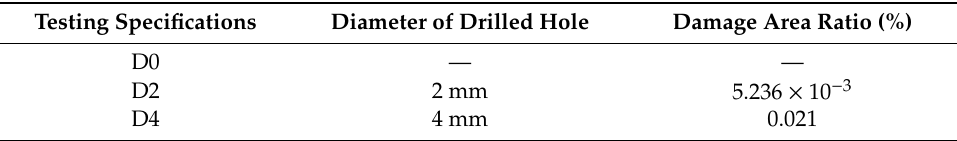
Table 1. Testing specifications of specimen-1.